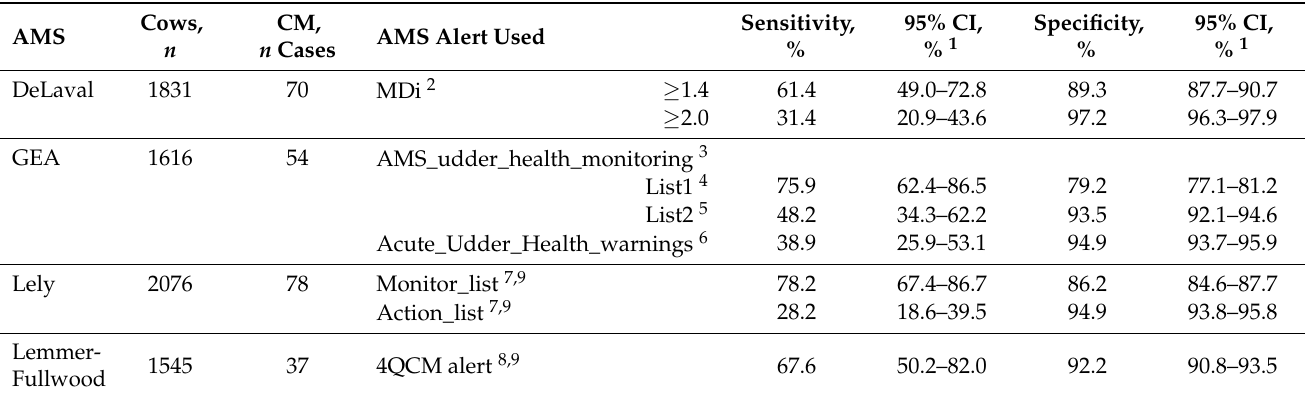
Table 5. Sensitivity and specificity of clinical mastitis (CM) alerts for AMSs from DeLaval, GEA, Lely and